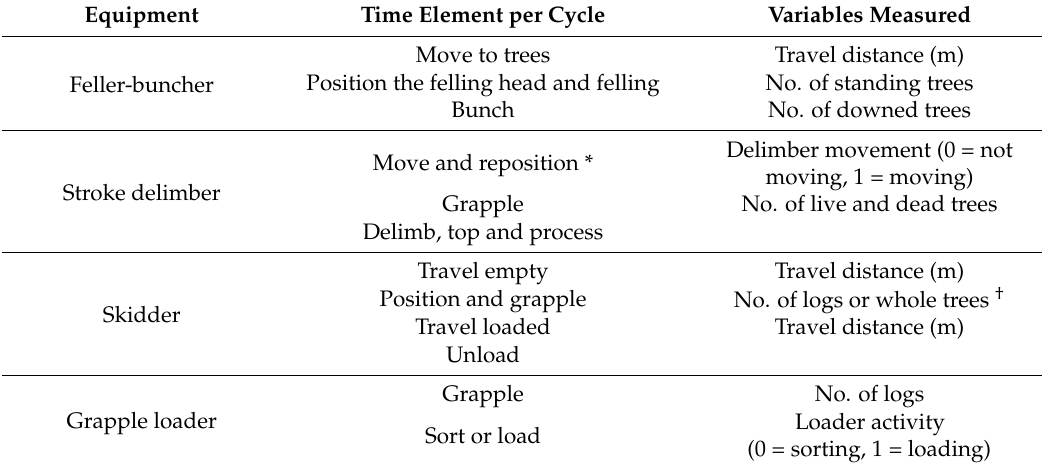
Table 3. Time elements and variables measured during detailed time study for the lop and scatter (LS) and whole-tree harvesting (WT)